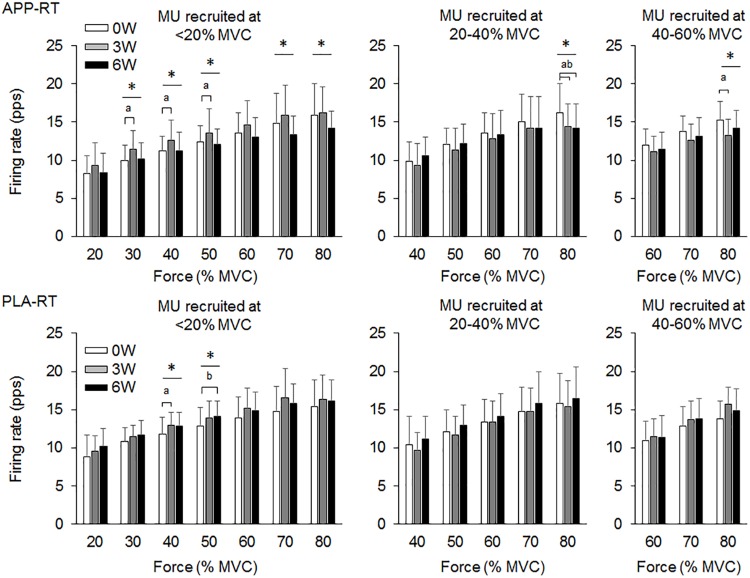
Motor unit firing rates of the group with fish protein intake and resistance training (APP-RT) and the group with placebo and resistance training (PLA-RT). MU, motor units. The symbols ∗, a, and b indicate significant differences (p < 0.05) among the periods, between 0 and 3 weeks, and between 0 and 6 weeks, respectively.